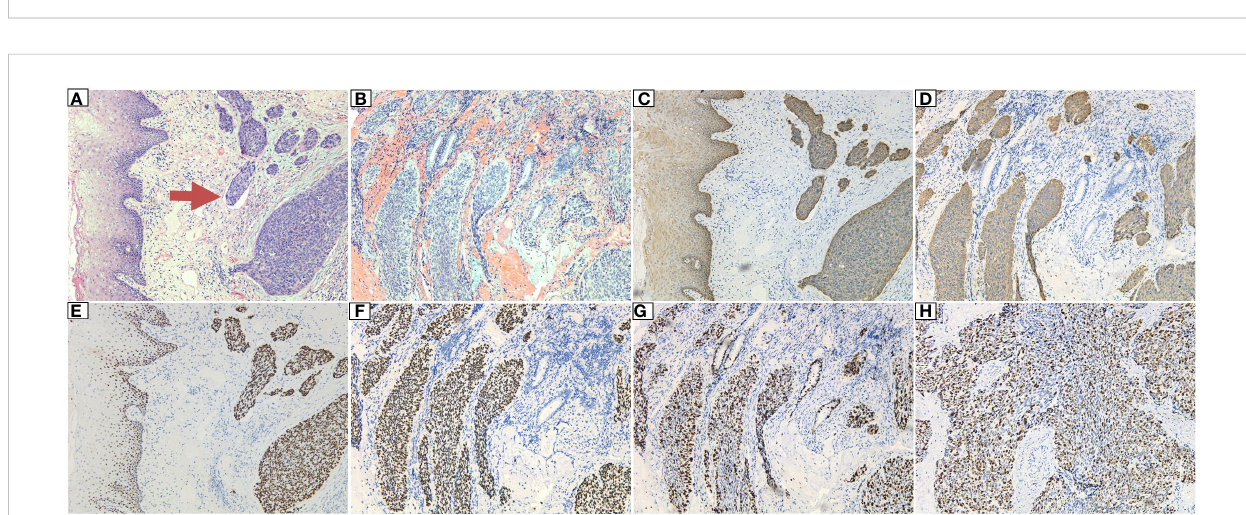
FIGURE 4 Postoperative pathology of the rectum: (A) The tumor cells had in fi ltrated the subepithelial interstitium in a nested, mass-like manner, and intravascular tumor emboli (indicated by the arrow) were visible, showing a clear boundary with the squamous epithelium near the rectum. (B) The tumor tissue showed mass and nested in fi ltrative growth, the epithelial-like cells outside the nest showed a basal cell-like arrangement, and residual mucinous glands were seen in the background of hemorrhage. (C, D) Magni fi cation: 10×10. Immunohistochemical marker CK5/6 (+). (E, F) Immunohistochemical marker P63 (+). (G, H) Immunohistochemical marker KI67 (high proliferation index,